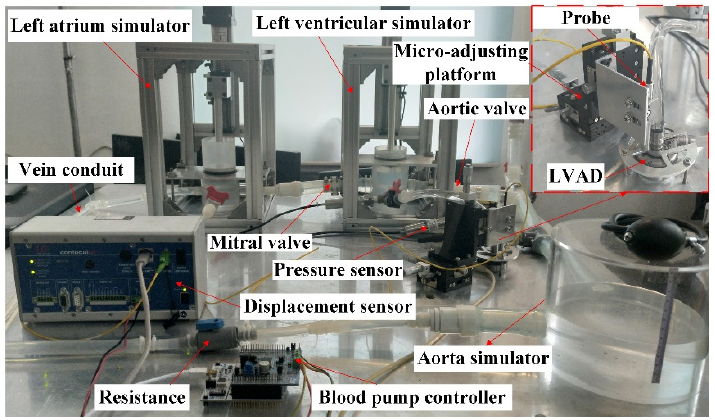
Figure 16. Extracorporeal mock circulatory loop.